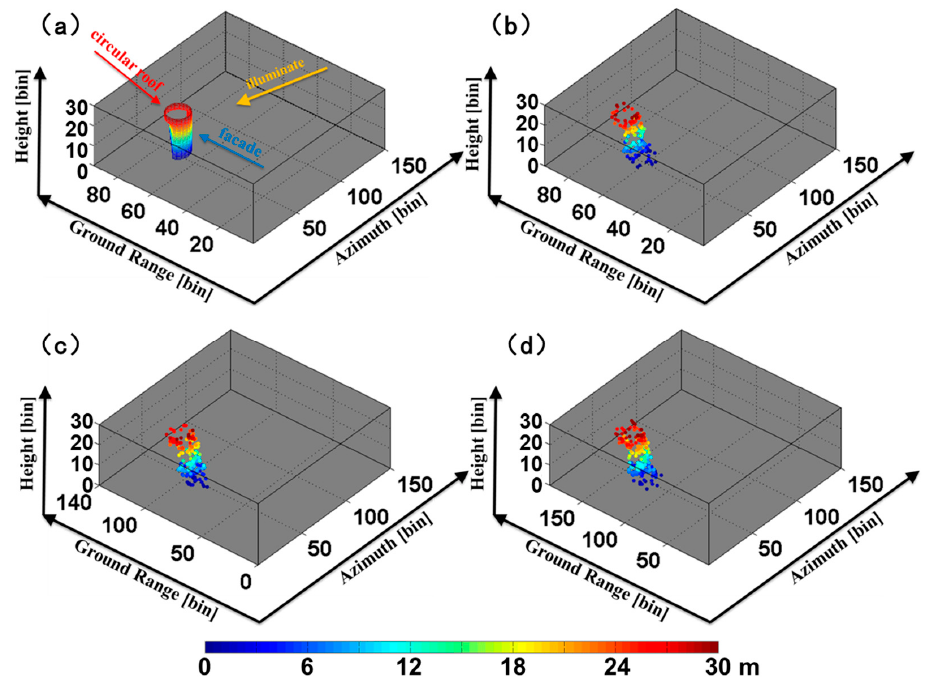
Figure 12. ( a ) 3D view of the target building and 3D visualization of the scatterers reconstructed with SAR tomography, after coordinate transformation from range to ground distance; obtained with ( b ) the CS 1D TomoSAR method, ( c ) CS-2D-TomoSAR with the range resolution enhanced 1.5-fold and ( d ) CS-2D-TomoSAR with the range resolution enhanced two-fold. The color is associated to the estimated height.